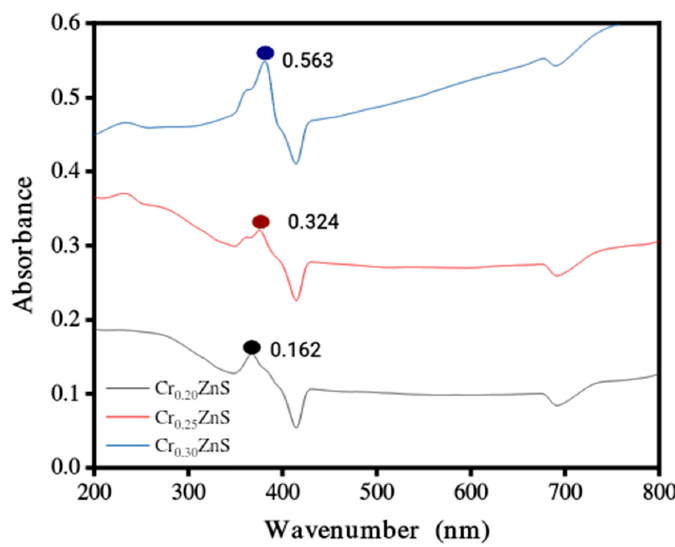
Figure 5. The band gap of Cr x ZnS with x = 0.20, 0.25, and 0.30 was found to be 2.68, 2.48, and 1.69 eV, respectively. These band gap values are lower than the standard value of bulk ZnS (3.6 eV) [23].